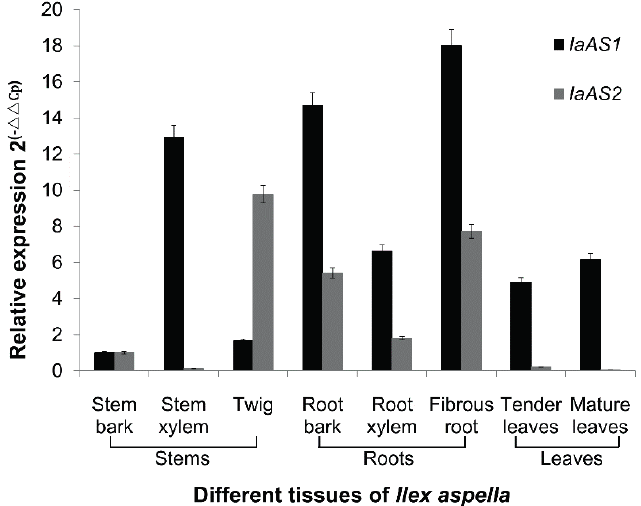
Figure 6. Expression patterns of IaAS1 and IaAS2 . Relative expression levels of both target genes in different tissues were normalised to the reference gene, β -tubulin , and further evaluated relative to the stem bark sample. Error bars represent the standard errors of the means calculated from three technical